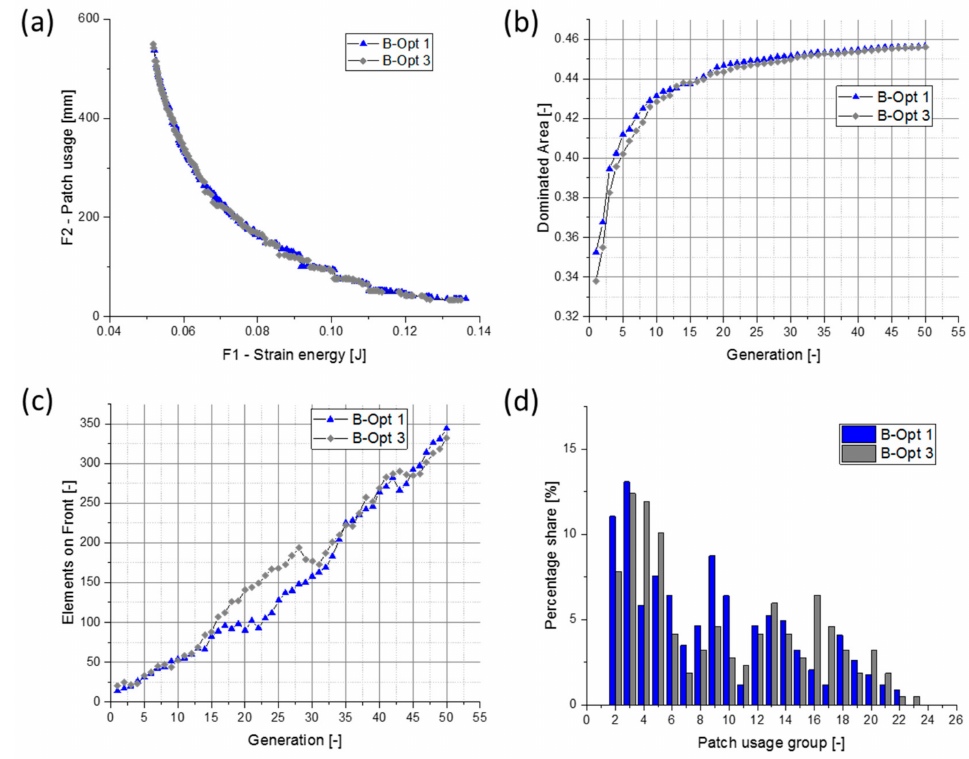
Figure 14. Comparison of the results for the variation of the replacement type (B-Opt 1: elitist replacement, B-Opt 3: below-limit replacement): ( a – d ) as in Figure 13.